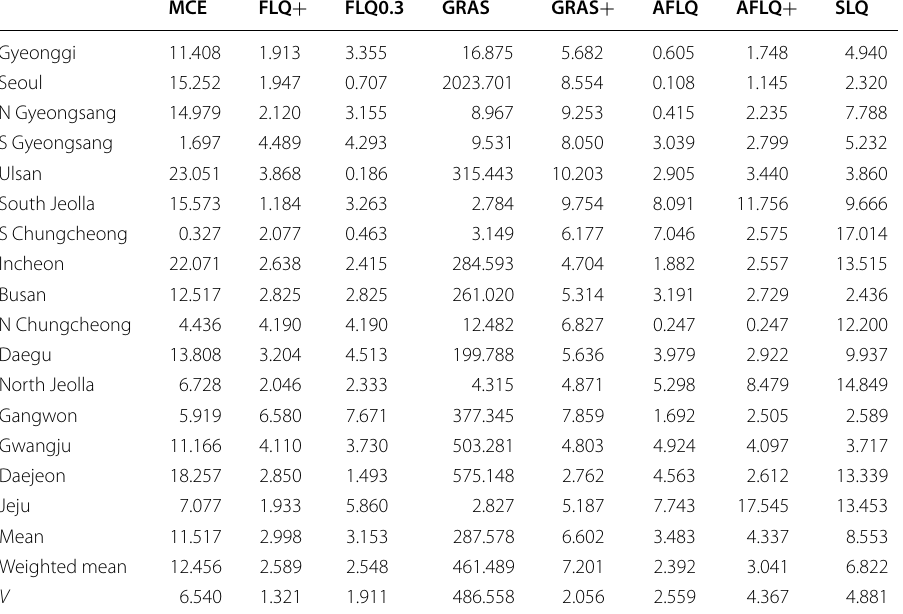
FLQ0.3 denotes the FLQ with a fixed δ